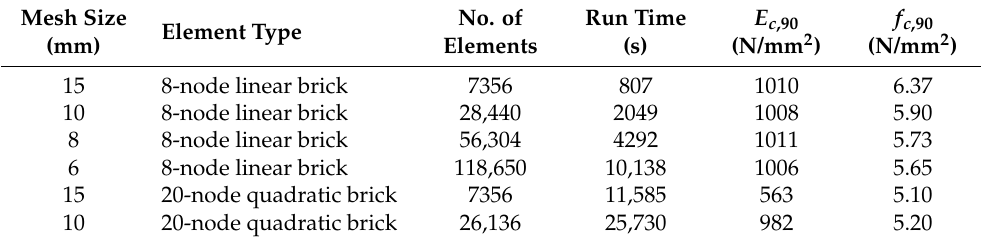
Table 2. Mesh dependency study for W80-F140-ww-cen .